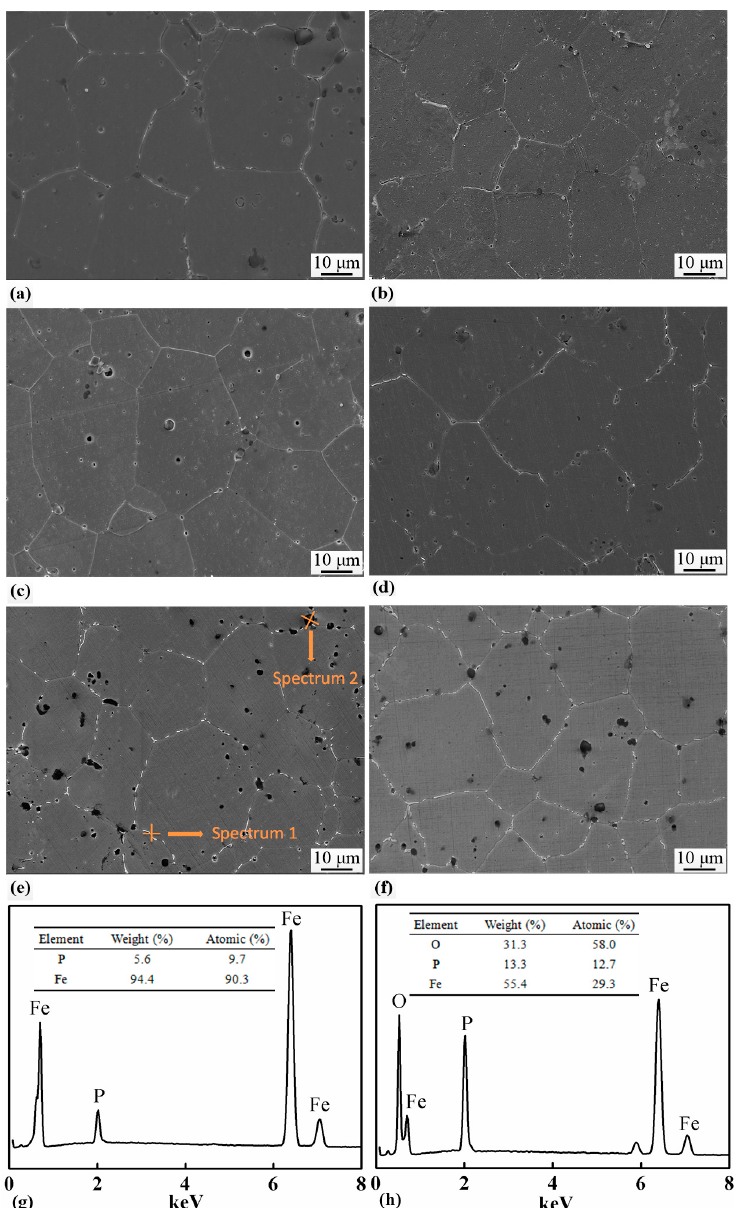
Figure 6. SEM micrographs of samples with ( a ) 0.6 wt.%, ( b ) 0.8 wt.%, ( c ) 1.0 wt.%, ( d ) 1.2 wt.%, ( e ) 1.4 wt.%, and ( f ) 1.6 wt.% contents of P, which were sintered at 1000 °C for 2 h. P-rich bright precipitates were distributed along grain boundaries in all the samples and P-containing black particles were seen in the Fe-1.4 wt.% and Fe-1.6 wt.% samples. EDS spectra revealed the chemical compositions of the bright precipitates ( g ) and the black particles ( h ).